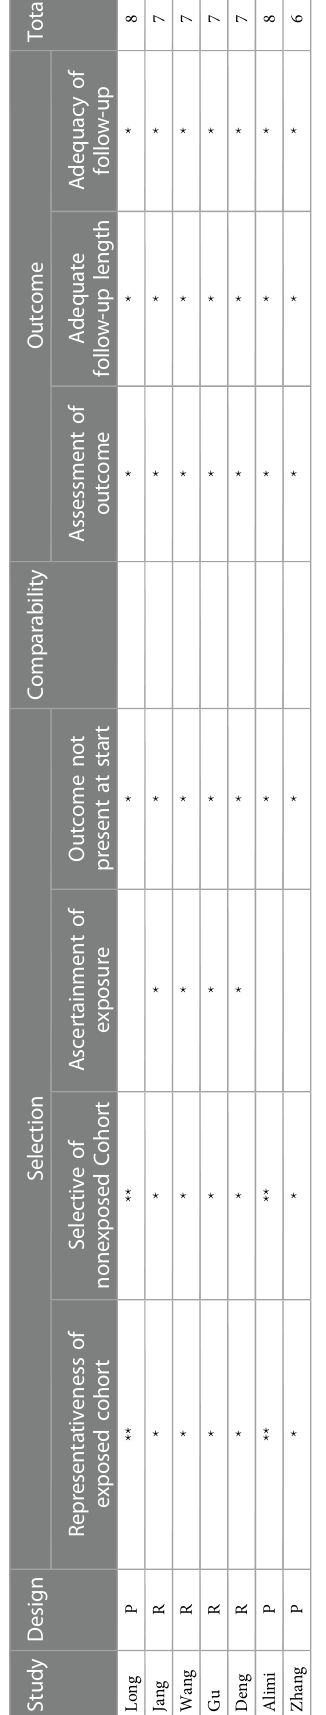
LPN group; OR: 0.85; 95% CI: 0.65 – 1.11; p = 0.23; I 2 = 0; fi xed- effective model; Figure 9